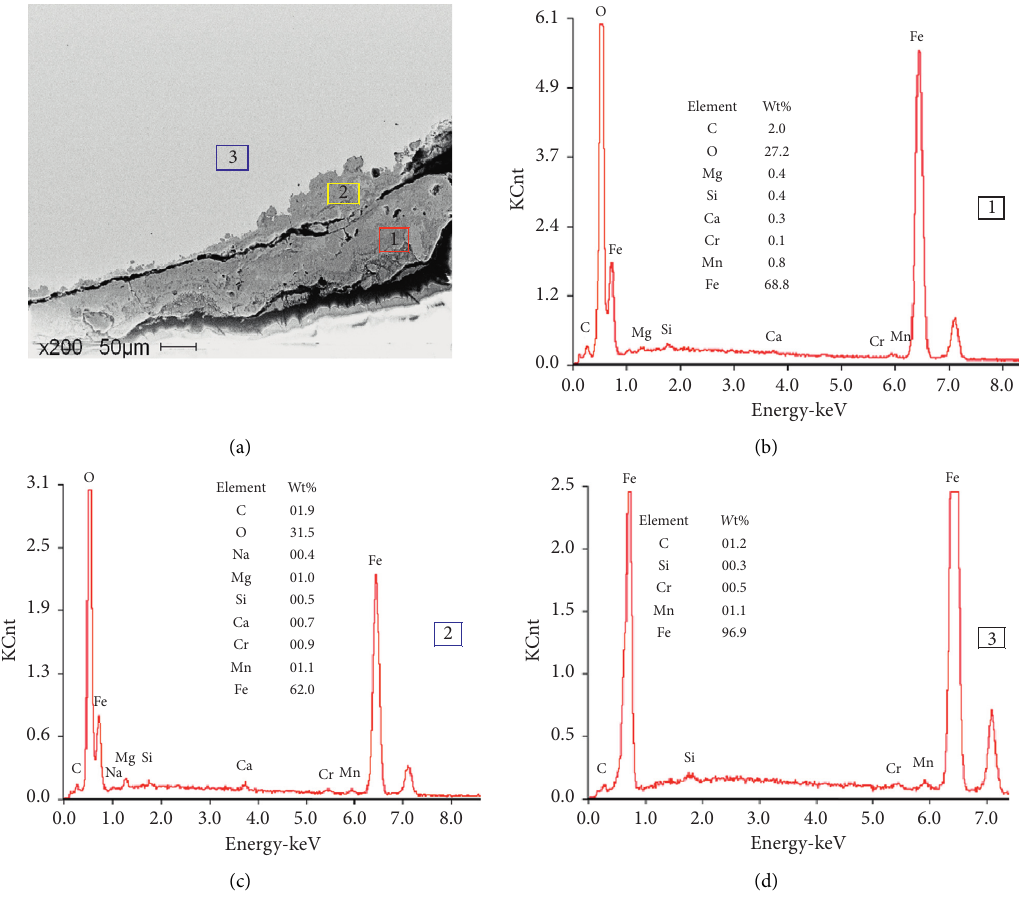
Figure 12: EDS energy spectrum analysis of corrosion products in the area without pits of transverse section. (a) Corrosion morphology. (b) Composition of near-surface corrosion products. (c) Composition of corrosion products near the matrix. (d) Composition of corrosion products in the matrix.